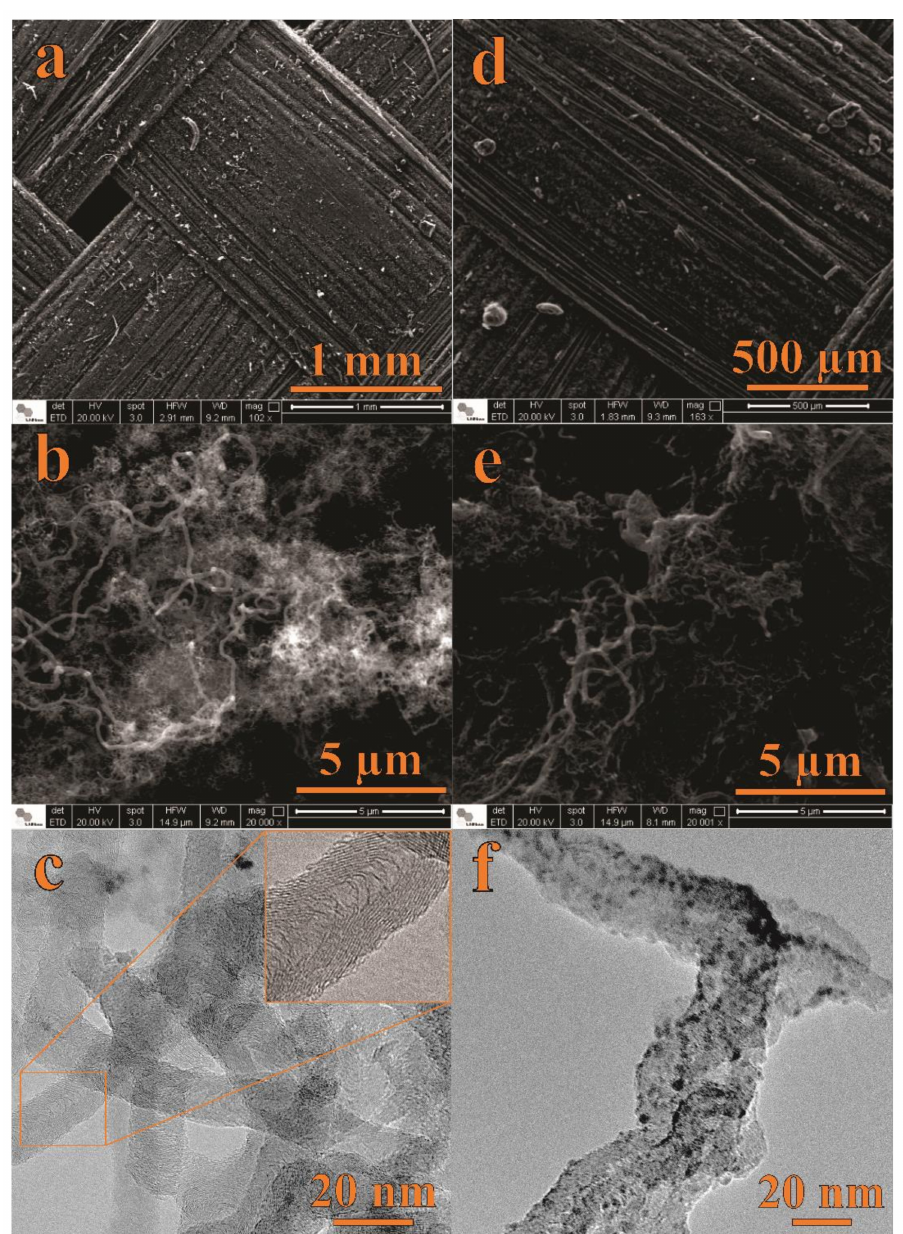
Figure 1. SEM and TEM data of CNFs ( a – c ) and NiO@CNFs ( d–f